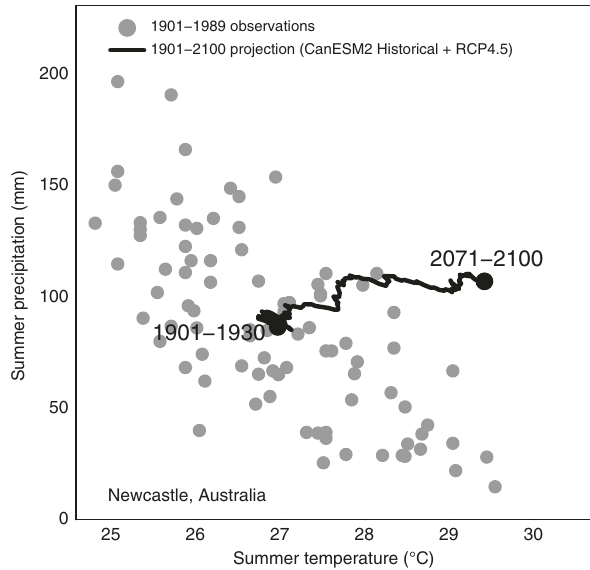
Fig. 1 Projected departure from historical climatic variability in a correlated temperature-precipitation regime. Summer precipitation and mean daily maximum temperature at Newcastle, Australia are negatively correlated ( r = − 0.7) in historical observations (gray dots). As a result, a climate change trajectory into warmer-wetter conditions (black line) can depart from the joint historical variability of temperature and precipitation while remaining within the individual historical ranges of variability of both temperature and precipitation. Historical observations are obtained from the CRU TS3.23 44 source stations. The climate change projection is the 30-year running mean of the CanESM2 Historical + RCP4.5 ensemble